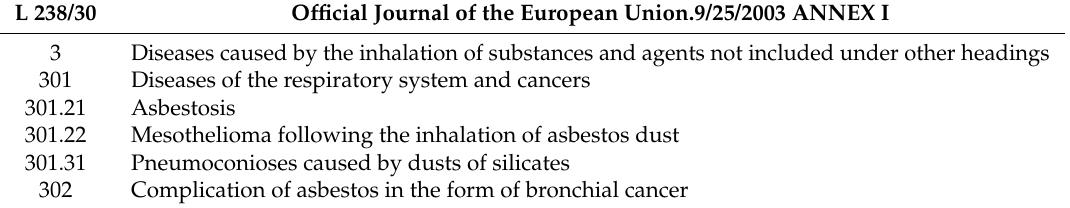
Table 2. The European schedule of occupational